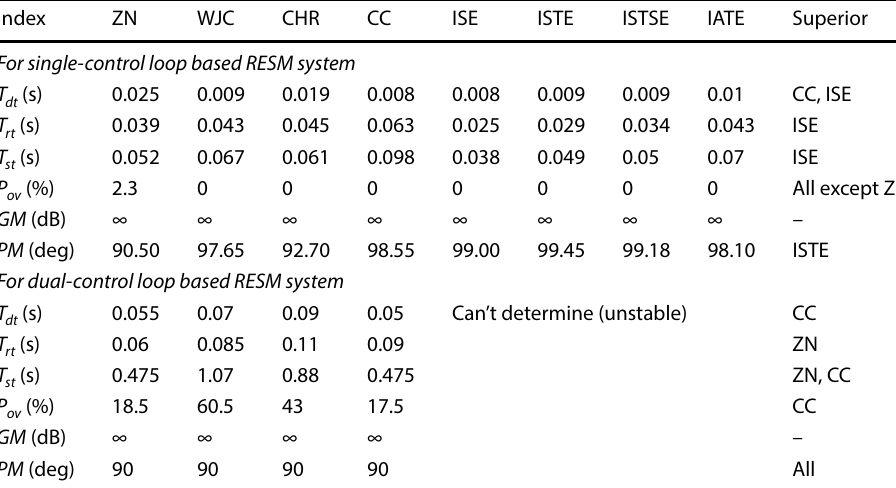
Table 9 Performance comparison of OLTR and EPI methods